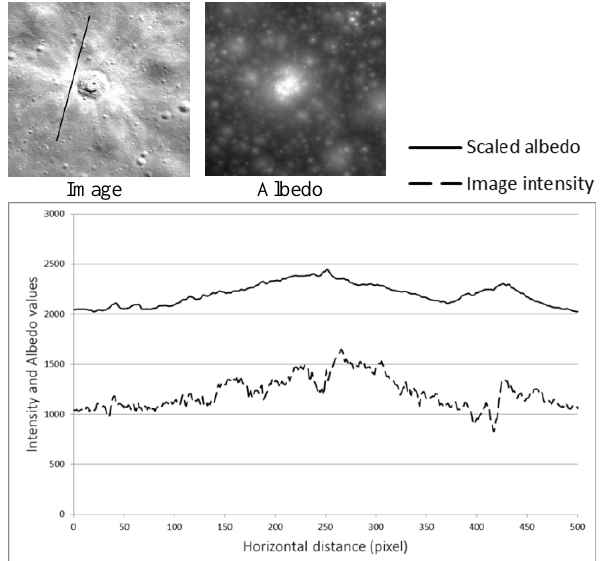
Figure 8. Intensity and albedo profiles of ejecta. The black solid line of the image denotes the location of the profile Table 9 summarises the number of conjugate points matched on each image pair. It is noted that the number of points found in original image pair is similar to that in slope maps while the number of points found in albedo maps is about half of the others. This is because the original image and slope maps preserve most of the details while albedo maps generally preserve features with apparent albedo changes. The absence of shading in albedo maps also suppresses interest point extraction; however, the points found in albedo maps will be better associated with features. The total number of unique matched points presented in the last row of Table 1 is more than a double of matching results from only the original image pair; this indicates that the combined approach significantly increases the population of conjugate points. For all pairs, the number of valid points (i.e., vertical error within 2m) is about 60% of total matched points; this implies that the matching accuracy is consistent throughout all combinations.